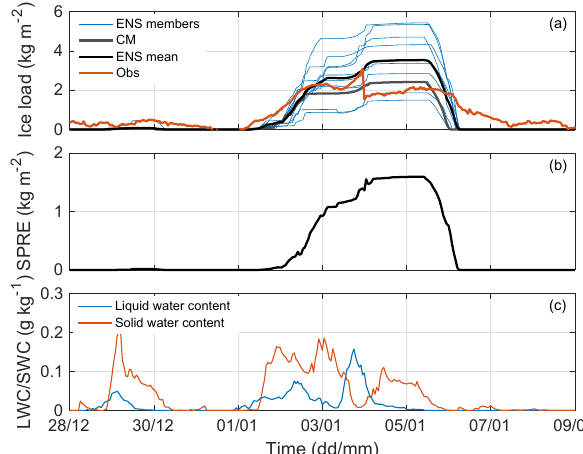
Figure 6. Site A. (a) Forecasted ice load in kgm − 2 . Blue lines are ensemble members, grey line is the CM and black line is the ENS mean. The ice load observations are in red. (b) The related spread of the ensemble members in ENS. (c) Forecasted ENS ensemble mean liquid water content in gkg − 1 for the